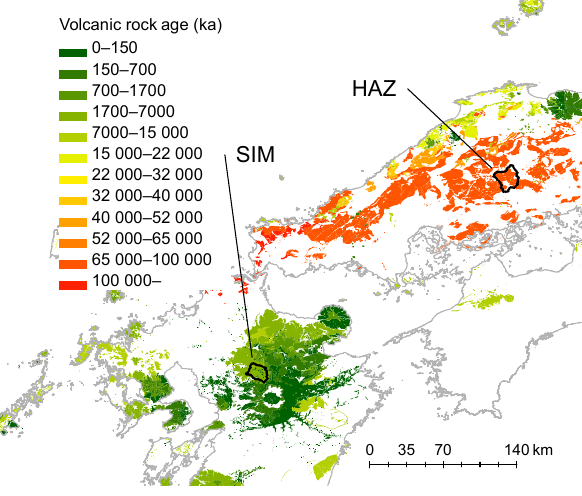
Figure 2. Study catchments in western